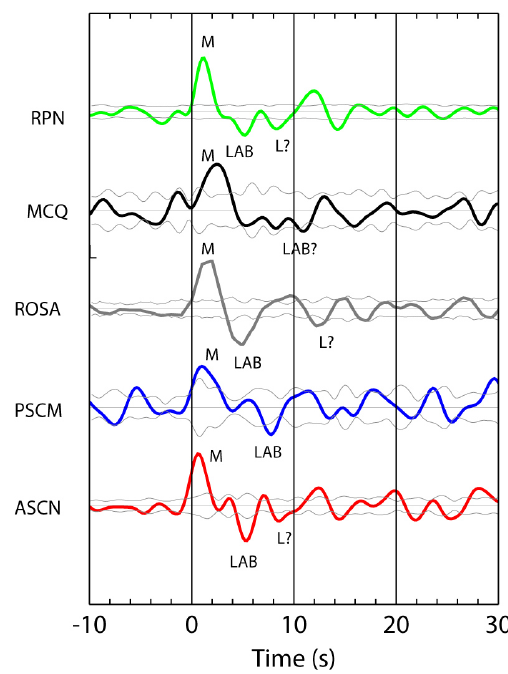
Figure 2. Observed P -receiver function stacks (solid lines) at the five stations. Before stacking, the receiver functions are low-pass fil- tered with a corner frequency of 3s and moveout corrected to a ref- erence slowness of 6.4s/ ◦ using the IASP91 Earth model. The two gray lines on both sides of the mean lines represent the 2 σ standard error estimated using bootstrap resampling technique. The color codes correspond to different stations: Black, MCQ; Red, ASCN; Blue, PSCM; Green, RPN and Grey, ROSA. Different disconti- nuities are marked as M, Moho; LAB, lithosphere–asthenosphere boundary and L. sub-lithospheric low-velocity layer.